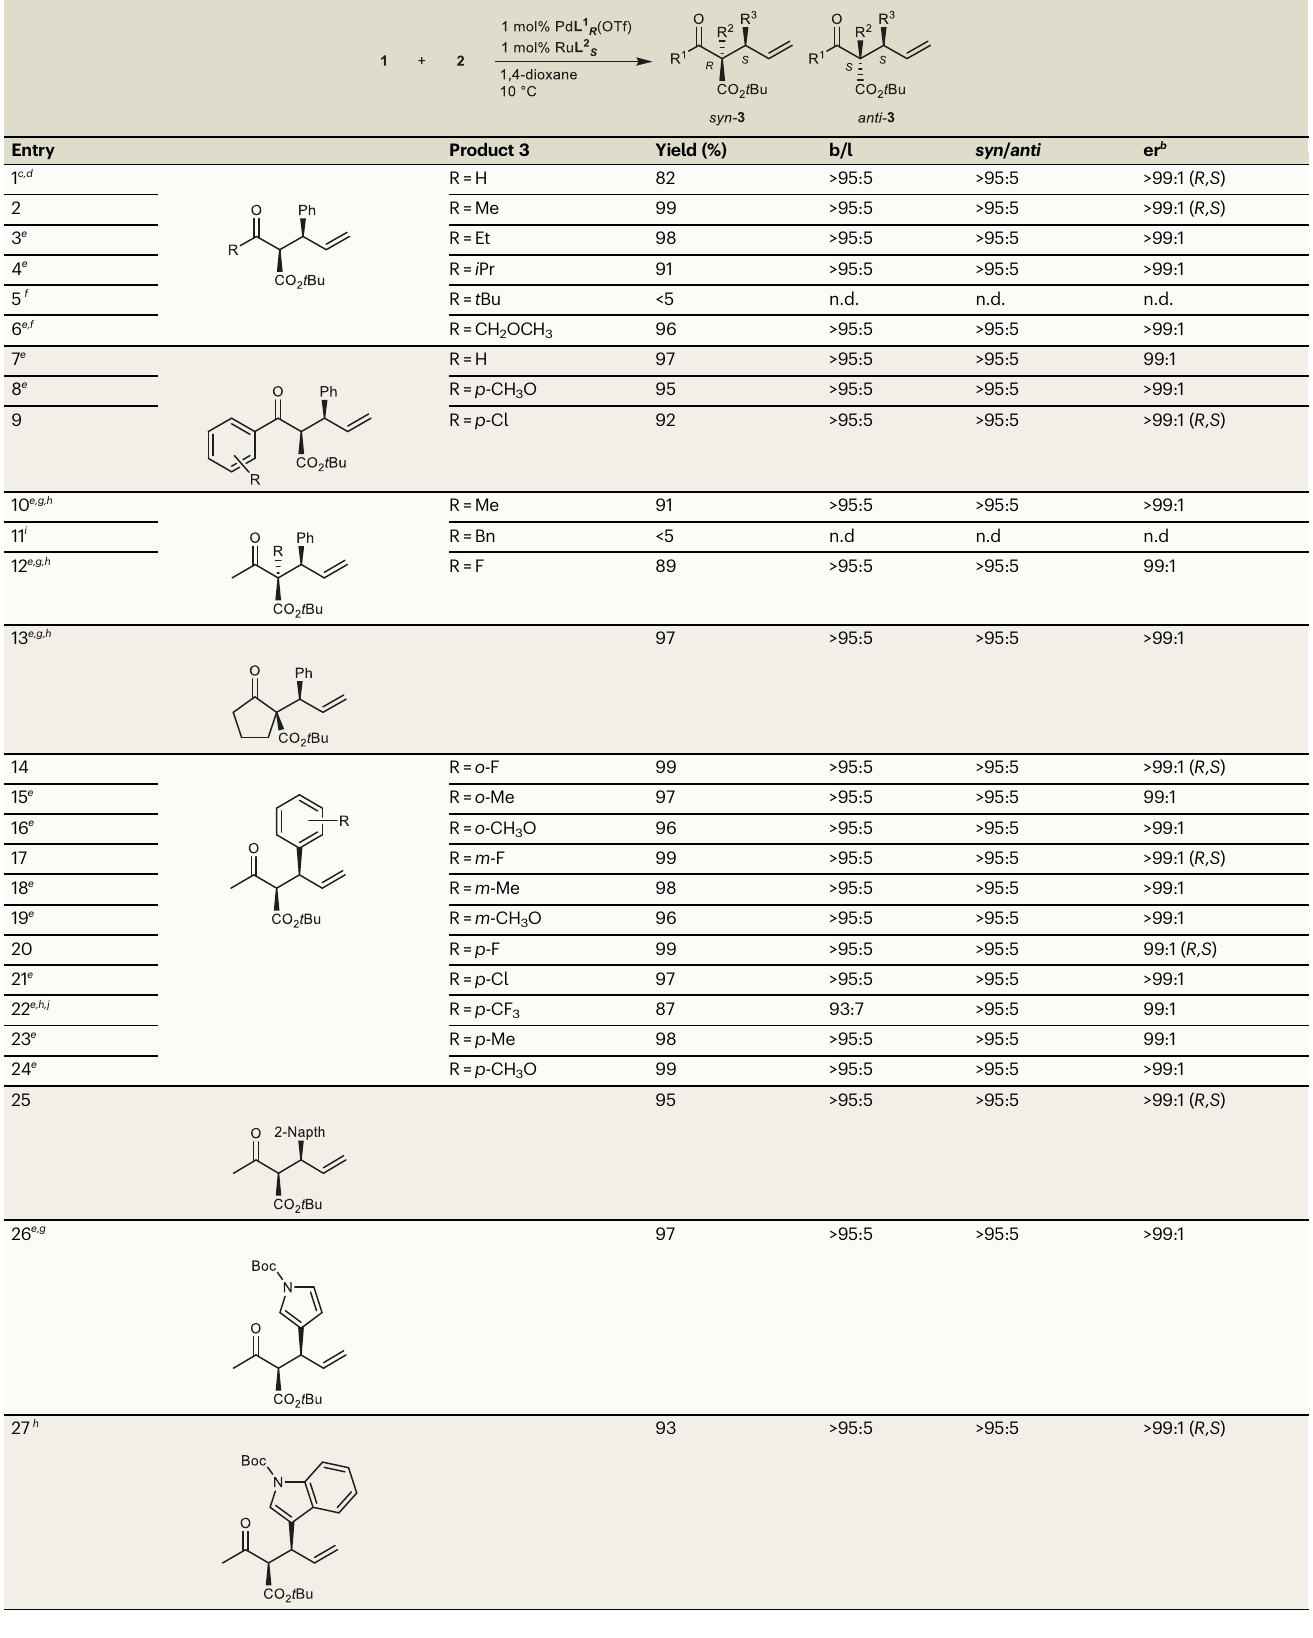
Table 2 | Generality of the PdL 1 R (OTf)/RuL 2 S -matched catalyst system